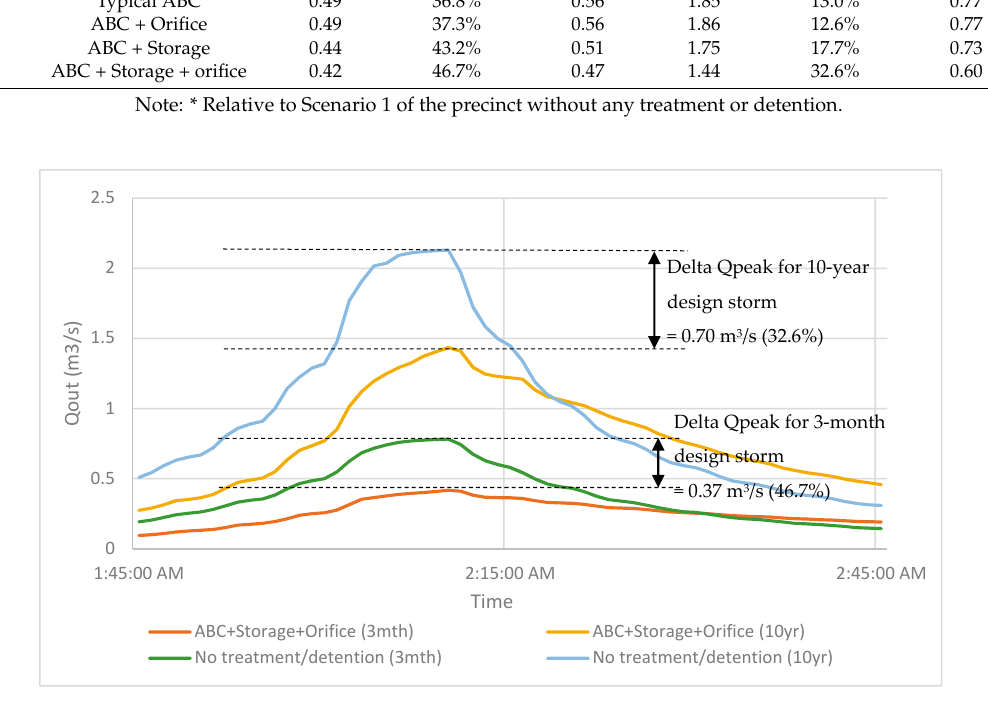
Table 4. Comparison of the outflow and effective C-value results of the precinct and alternative scenarios for the 3-month and 10-year design storms.